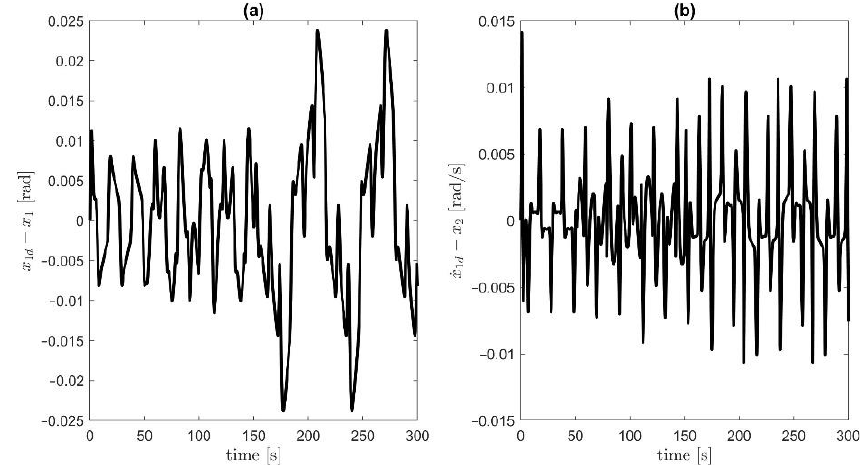
𝐸 1 , ( b ) tracking error 2 .